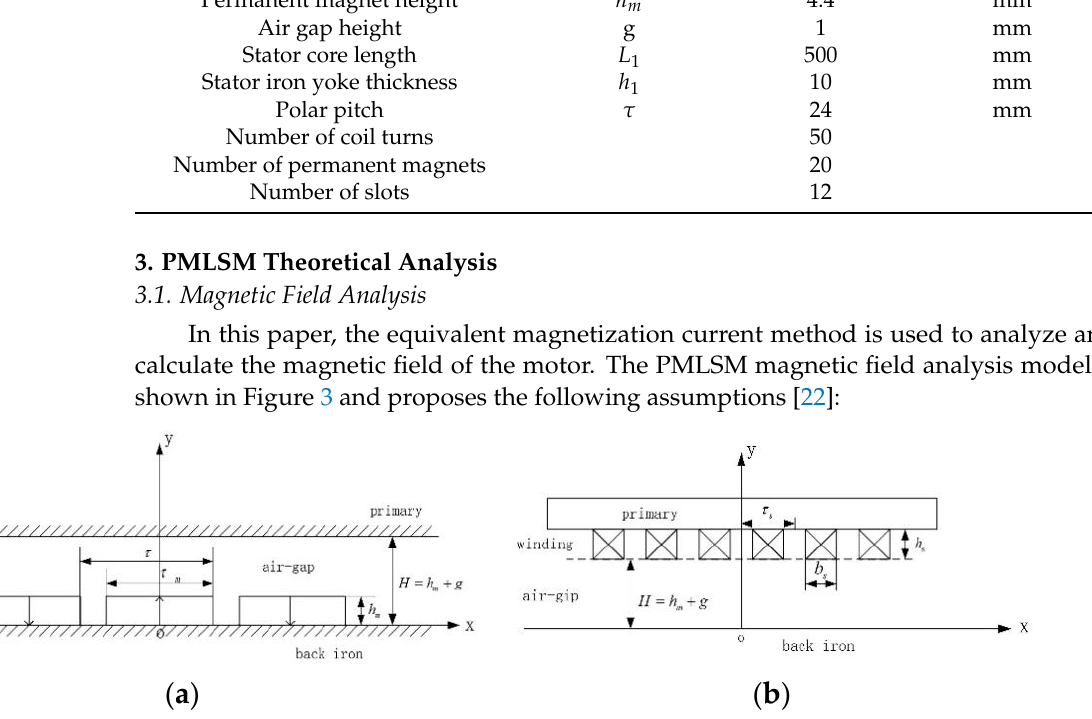
Figure 3. PMLSM magnetic field analysis model: ( a ) Permanent magnet magnetic field analysis model ( b ) Magnetic field analysis model of armature windings.